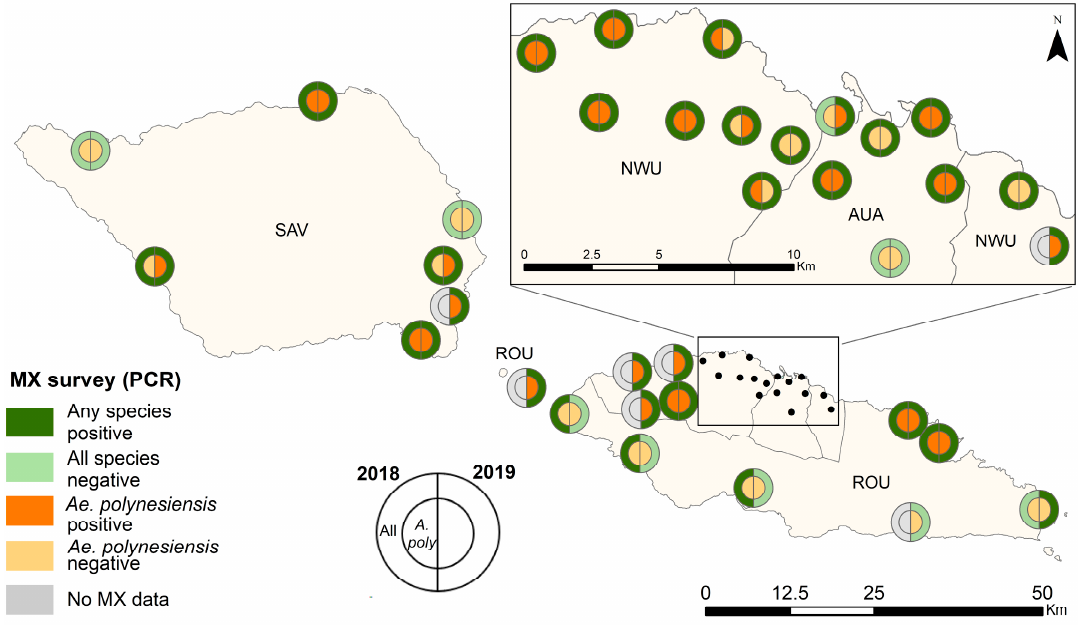
Figure 3. Presence of female mosquitoes ( Ae. polynesiensis and “any species”) PCR-positive for W. bancrofti by primary sampling unit (PSU), Samoa. Data from 2018 shown in the left semicircle, and 2019 in the right semicircle.